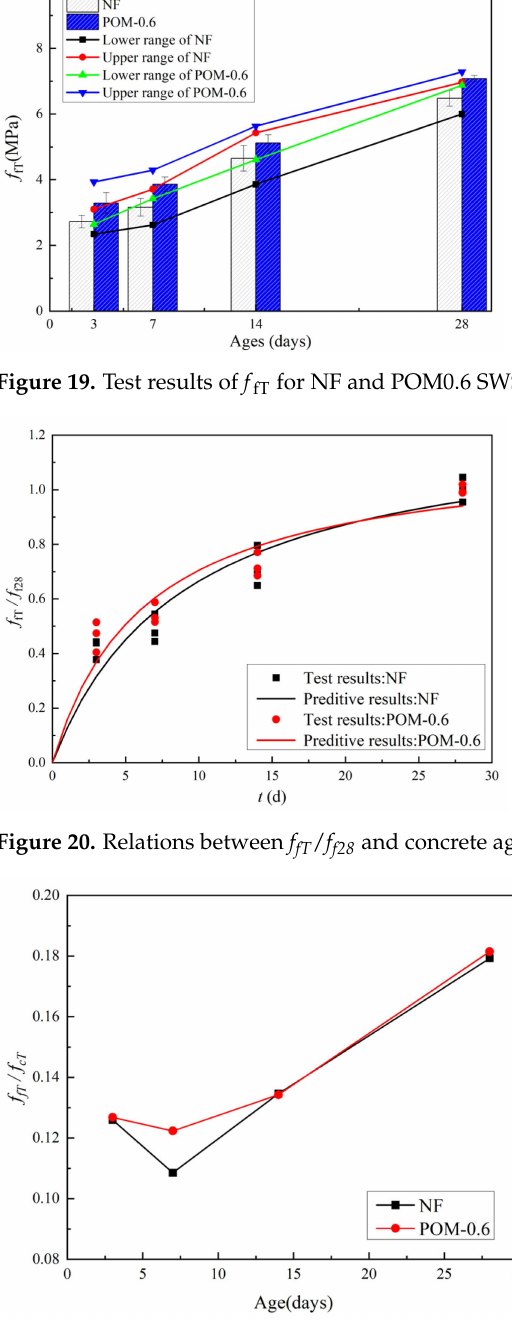
Figure 21. Relations between f fT and f cT